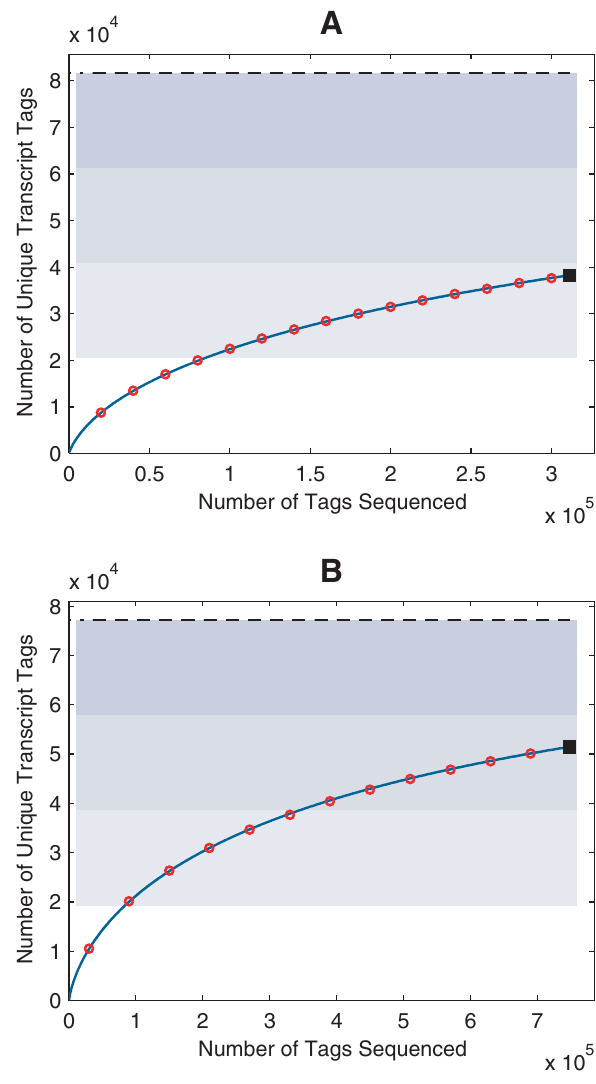
Figure 6. Sampling growth curve and transcriptome diversity estimation. Number of unique transcripts (solid square) identified in Lib843 (A) and the pooled library (B) as well as the sampling histories (red open circle) and predicted growth curve (blue solid line) are plotted. Blue-shaded areas divide the estimated transcriptome diversity S (black dashed line) into four